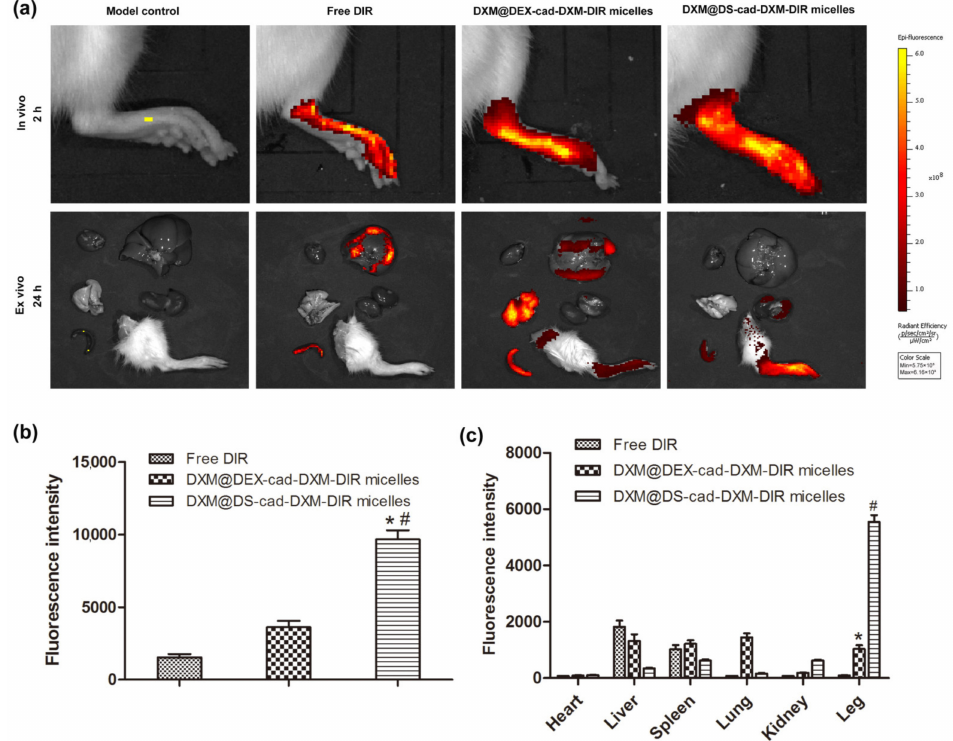
Figure 6. In vivo images of the inflamed joints and ex vivo images of the major organs from AIA rats after administration of different formulations ( a ). The fluorescent intensity in the inflamed joints for 2 h in vivo ( b ) and in the major organs for 24 h Ex vivo ( c ) from the fluorescence images. Data are presented as the mean ± SD (n = 3, * p < 0.05, # p <